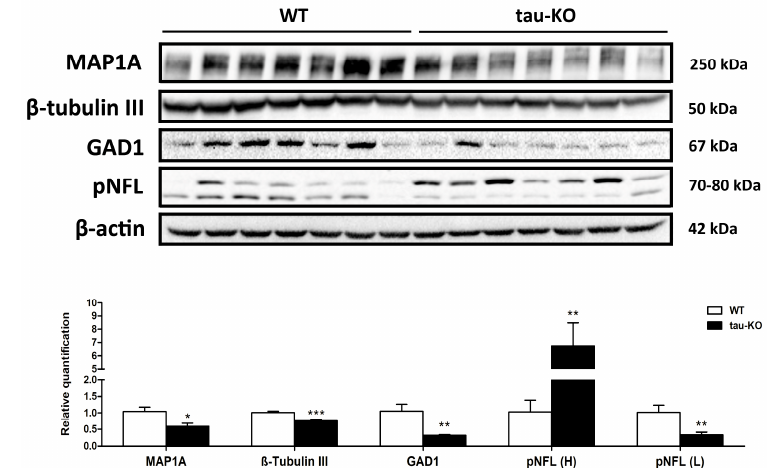
Figure 5. Western blotting of the cerebral cortex of tau-KO and WT mice aged twelve months. A significant reduction of MAP1A, β -tubulin III, and GAD1 is found in tau-KO mice. Phosphorylated neurofilament heavy chain (pNFL-H) is increased, and phosphorylated neurofilament light chain (pNFL-L) is decreased in tau-KO mice. * p < 0.05, ** p < 0.01, and *** p < 0.001.